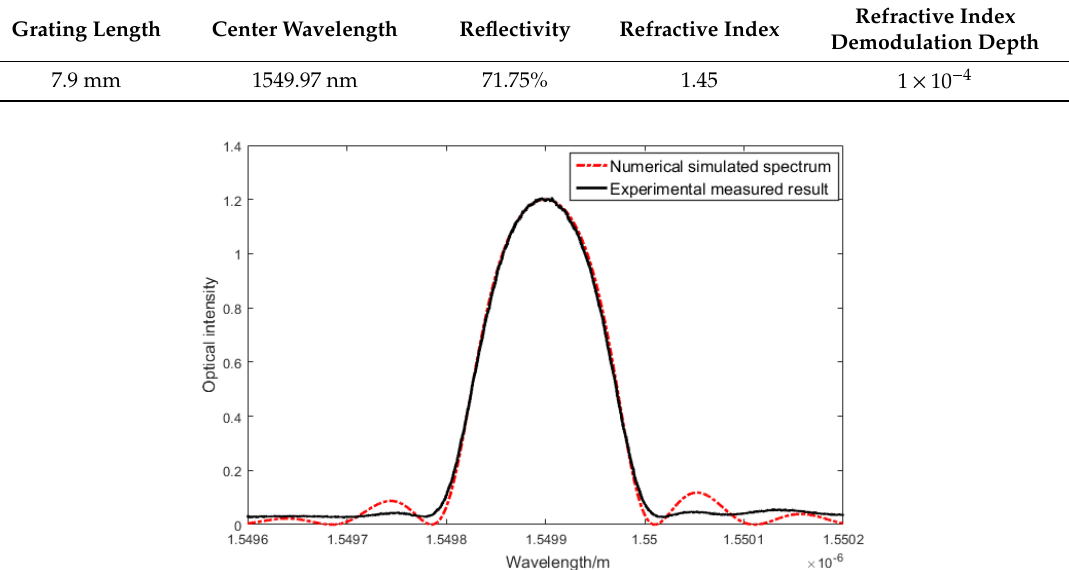
Figure 6. Fiber Bragg Grating (FBG) spectrum simulation, numerical vs. experimental results. Table 1. Fiber Bragg Grating (FBG) sensor parameters.